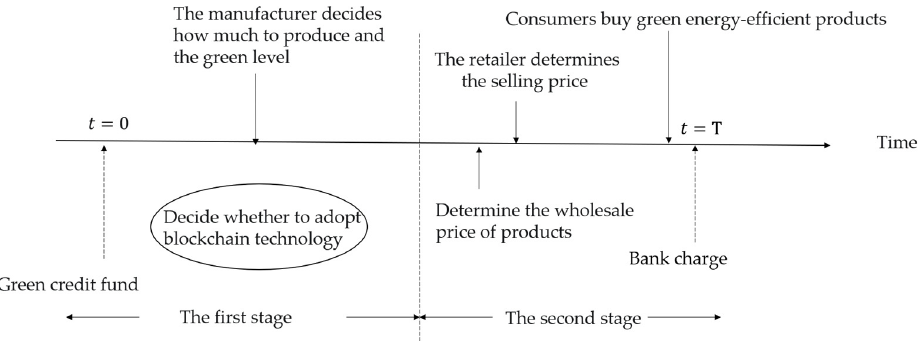
Figure 1. Sequence of events.